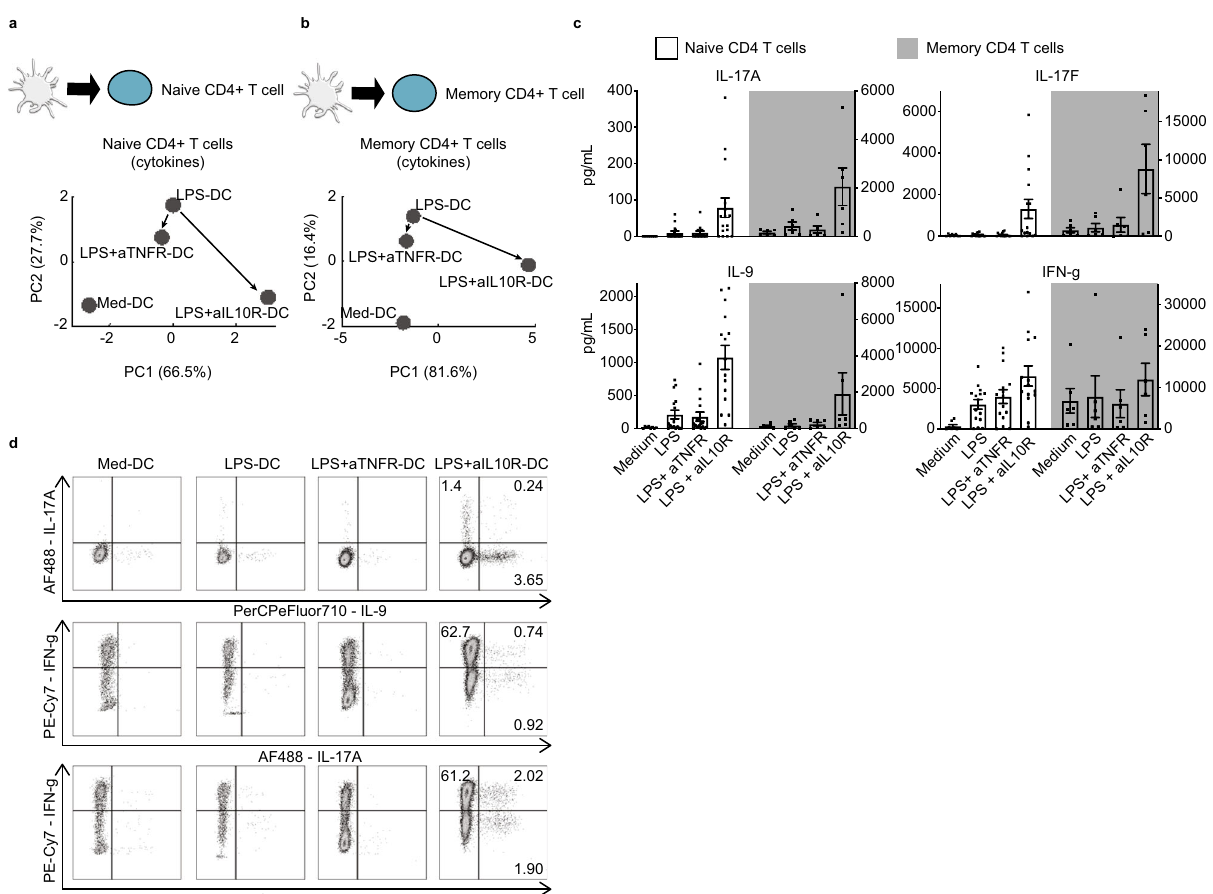
Fig. 6 IL-10 but not TNF loop dictates T helper polarization by LPS-DC. a , b Supernatants of CD4 + naive ( a ) and memory ( b ) T cells, co-cultured with the indicated DCs, were analyzed for the presence of T helper cytokines by CBA: IL-2, IL-3, IL-4, IL-9, IL-10, IL-17A, IL-17F, and IFN- γ ( a ) and all the above in addition to IL-5, IL-13 TNF, and GM-CSF ( b ). Results are shown in a two-dimensional principal component analysis (PCA). Dots represent mean of 9 ( a ) or 6 ( b ) independent co-culture experiments. c Histogram representation of 4 cytokines present in the supernatant of naive (white bars, left axis) or memory (black bars, right axis) supernatant ( n = 16 biologically independent samples for naïve CD4 T cells except Medium condition where n = 8 biologically independent samples, n = 6 for memory CD4 T cells). Data are presented as mean values ± SEM. d CD4 + naive T cells were analyzed for IL-17A, IL-9, and IFNg production using intracellular staining FACS. Percentage of positive producers is given. Shown is one representative out of 3 independent experiments. Some schematic art pieces were used and modi fi ed from Servier Medical Art, licensed under a Creative Common Attribution 3.0 Generic License. http://smart.servier.com/ ( a